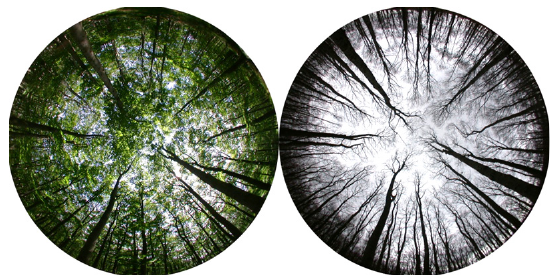
Figure 2. Hemispherical image of summer (left) and winter (right) stand conditions. Corrected area = area measured in summer-area measured in winter.